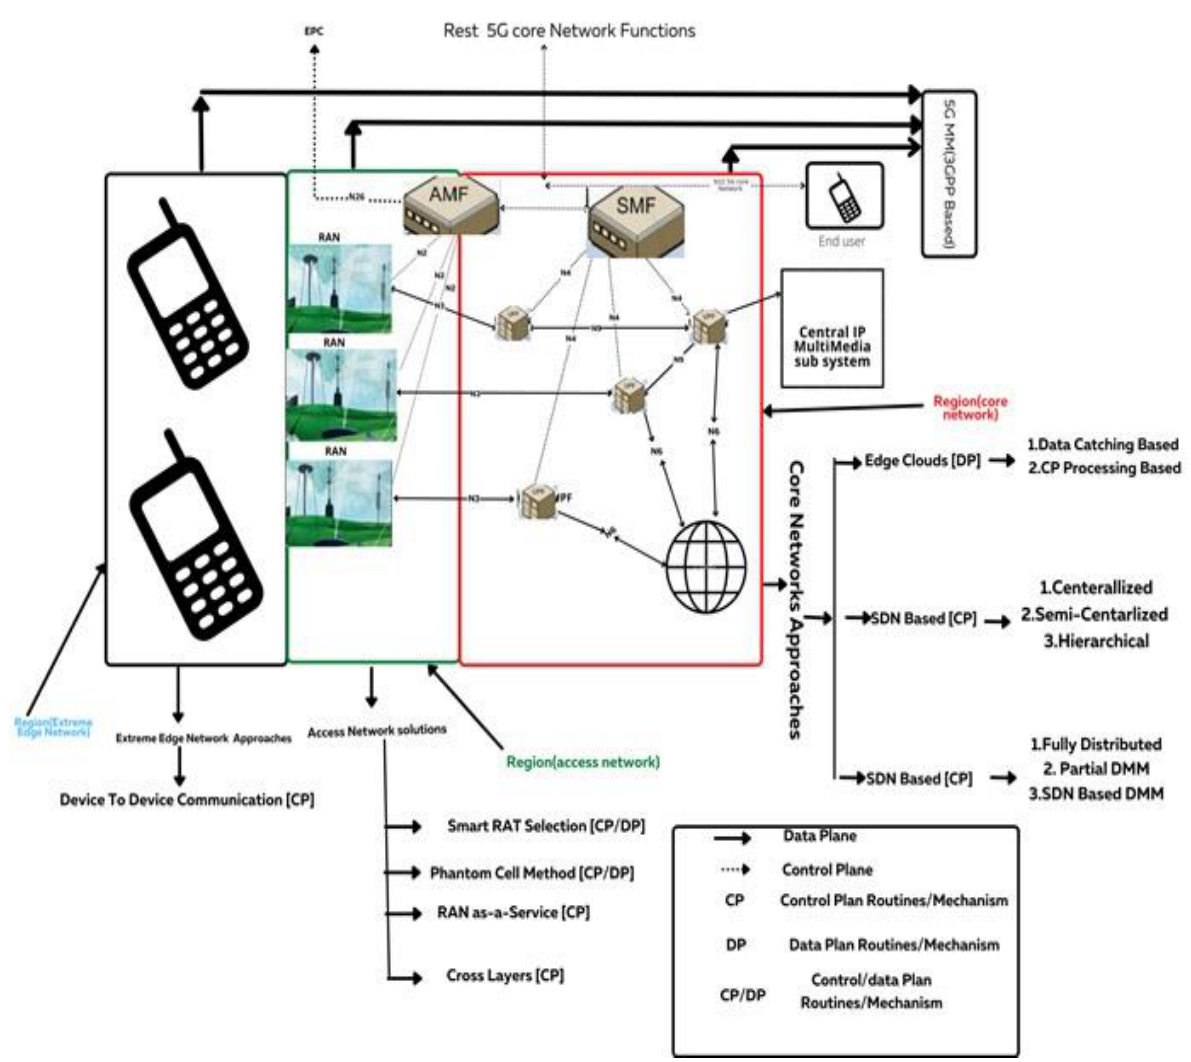
Figure 1. Organization of the innovative mobility management approaches in the 5G design.